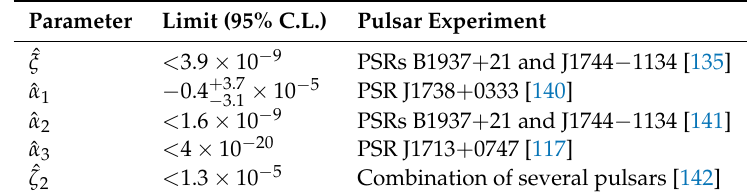
Table 1. Limits for strong-field PPN parameters from pulsar experiments. A “ < ” means that the limit applies to the absolute value. Some of these limits are significantly (orders of magnitude) tighter than limits on the corresponding (weak-field) PPN parameter obtained in the Solar System (see [3] for a